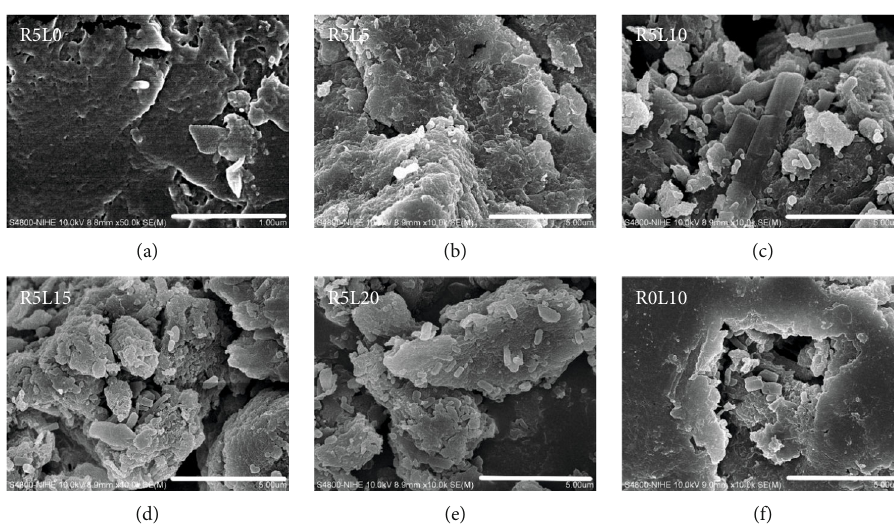
Figure 5: FESEM image of NPB with ginsenoside Rb1 5wt.% and (a – e) Lov 0, 5, 10, 15, and 20 wt.% and (f) Lov